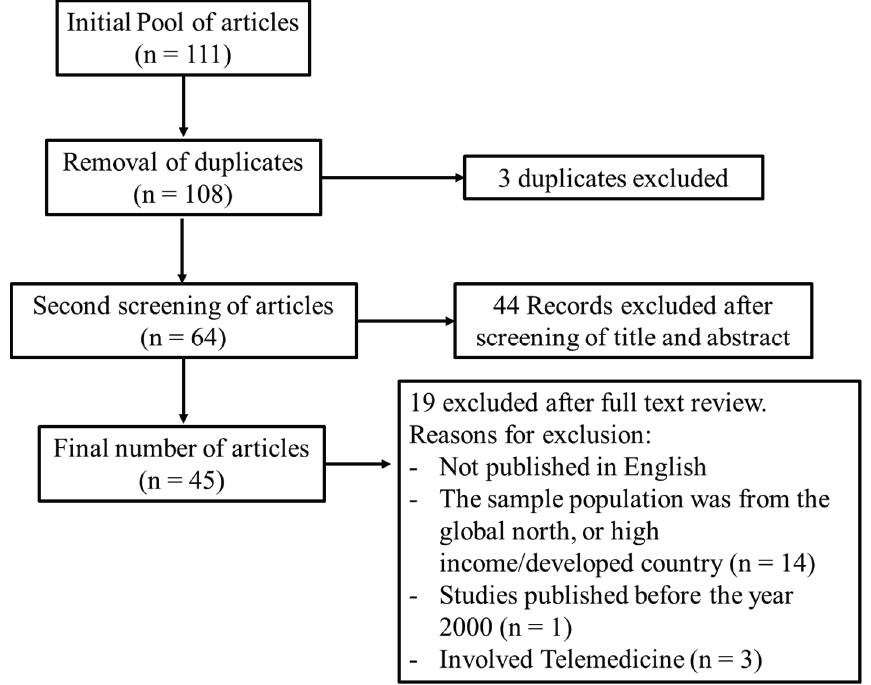
Figure 1. Flowchart of the studies included in the